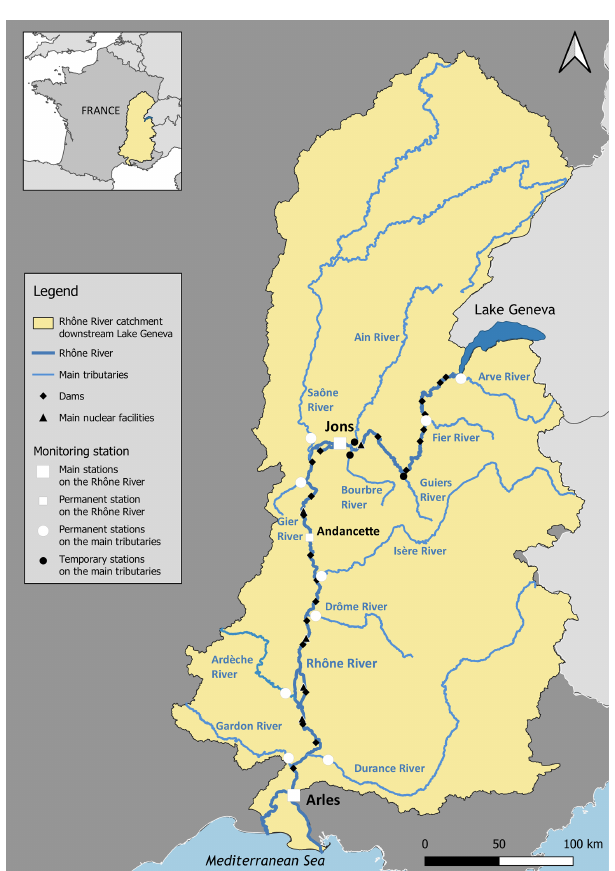
Figure 3. Location of the OSR monitoring stations along the Rhône River and at the outlets of the main tributaries, from Lake Geneva to the Mediterranean